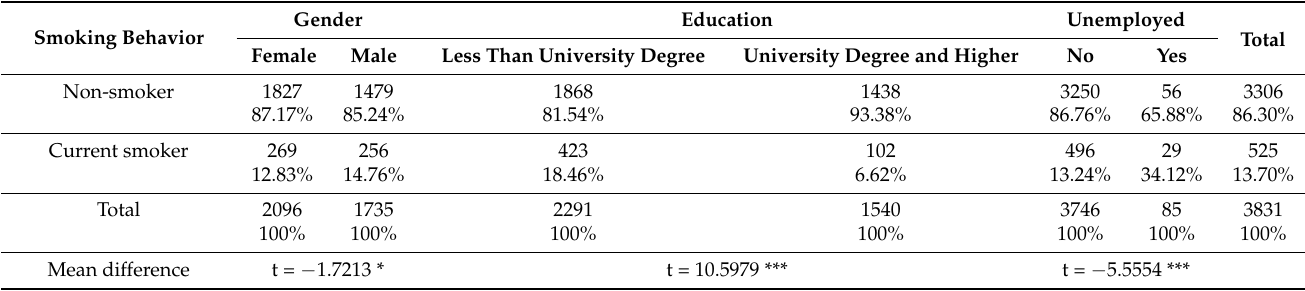
Table 4. Distribution of smoking behavior by demographic characteristic.